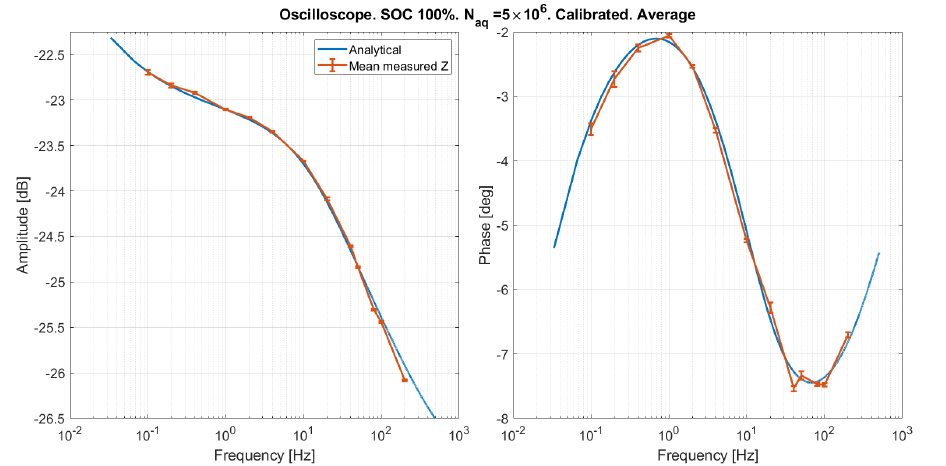
Figure 16. Mean and standard deviation over five repeated measurement of the emulated